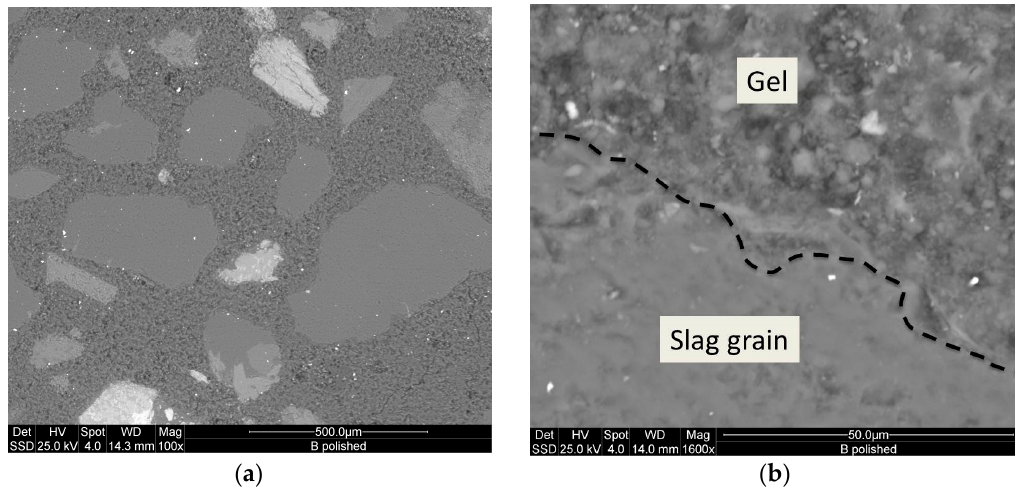
Figure 9. ESEM microstructure of black slag-based AAS mortars showing: ( a ) overall microstructure with quartz and iron-rich aggregates (solid-solution) embedded into the matrix; ( b ) interface zone demonstrating good adhesion bonds between aggregates.